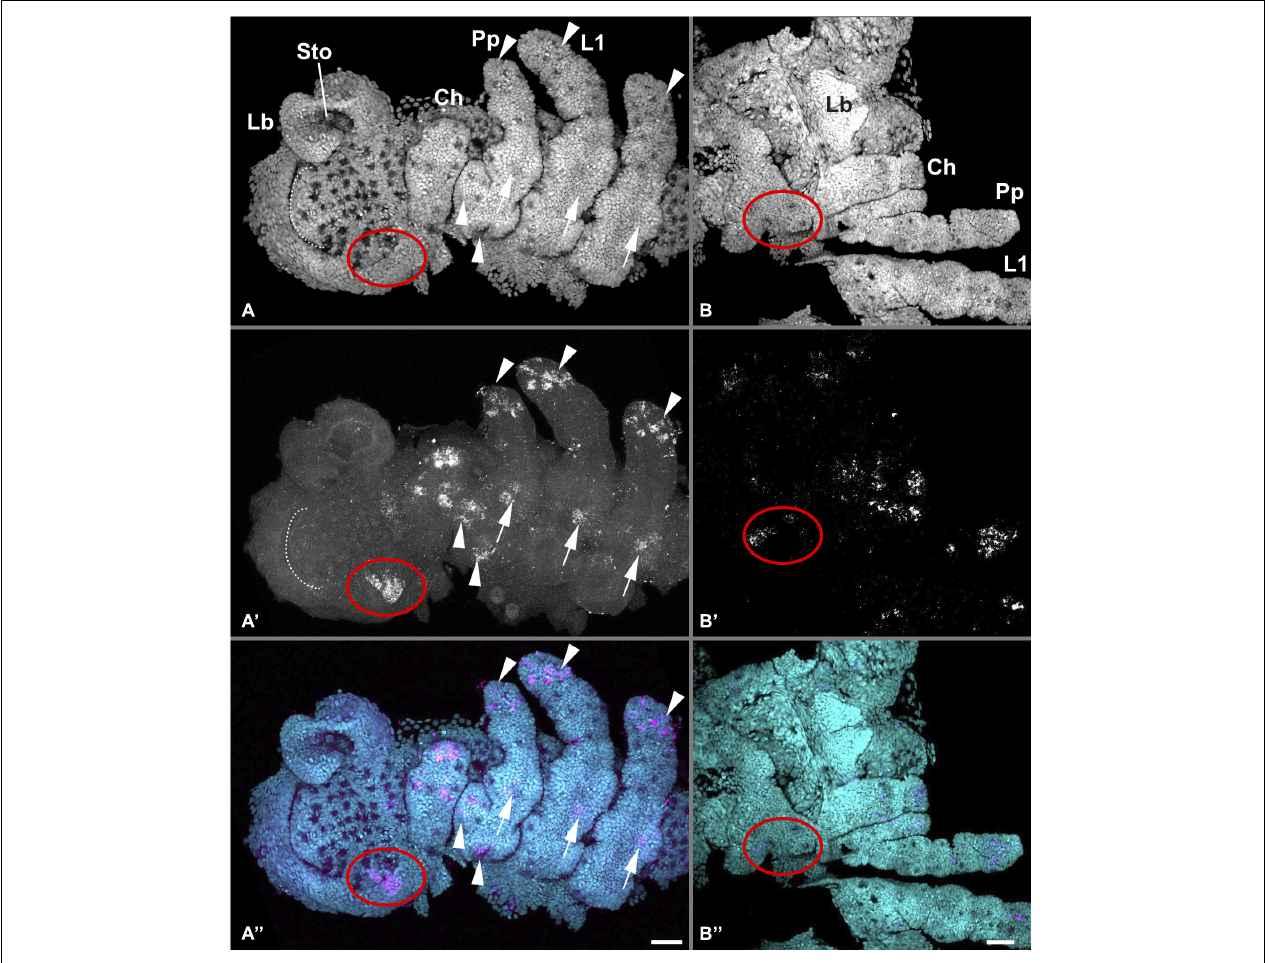
FIGURE 3 | Detailed embryonic Pt-Pax2.1 expression in the head. Red ellipses mark Pt-Pax2.1 expression domains in the eye primordia throughout embryonic development, white dotted line marks the anterior furrow in the head lobes. Left panels (A–A”) show the right anterior half of an embryo including the head lobes and prosomal segments until the second leg segment during early embryogenesis coinciding with brain differentiation (stage 10). Pt-Pax2.1 is expressed in the developing lateral eye primordia next to the lateral furrow (red ellipse) ventral neuroectoderm (arrows, see also Supplementary Figure 7B for VNE specific Z-projection), and in proximal and distal spots in the appendages (arrowheads, see also Supplementary Figure 7A for appendage specific Z-projection). (B–B”) Head and right appendages (chelicera, pedipalp, L1) during mid-ventral closure (stage 13.1 late) showing diffused Pt-Pax2.1 gene expression in the appendages and as patches in the developing eyes. Flat mounted preparations; anterior is to the left in all panels. Cyan is nuclear DAPI staining; magenta is Pt-Pax2.1 specific expression detected with FAST RED. Lb, labrum; Sto, stomodeum. Prosomal appendages: Ch, chelicerae; Pp, pedipalps; L1, 1st walking leg. Scale bar represents 50 µ